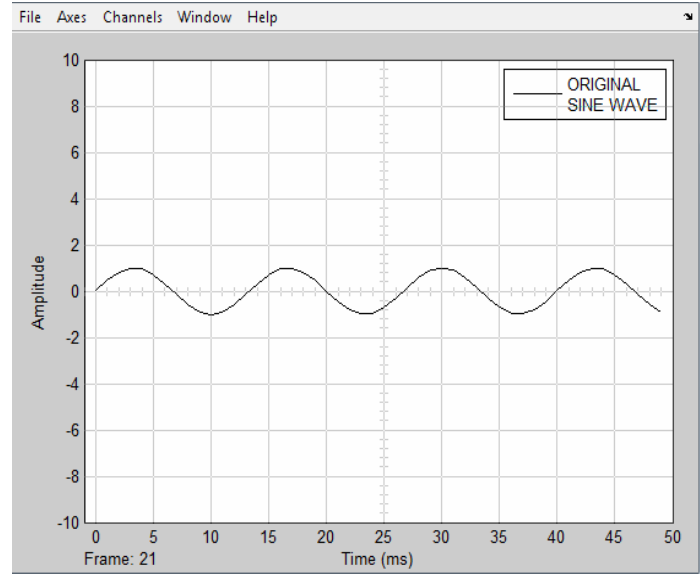
Figure 7. The original sine wave used in the Simulink model.